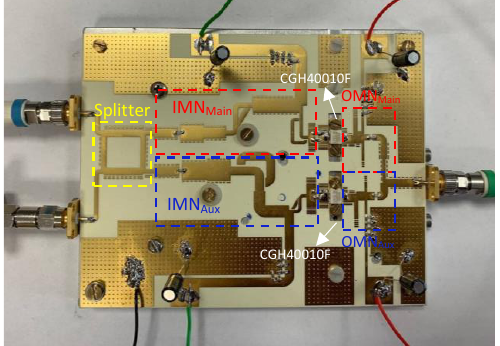
Figure 8. Photograph of the fabricated class-J DPA.